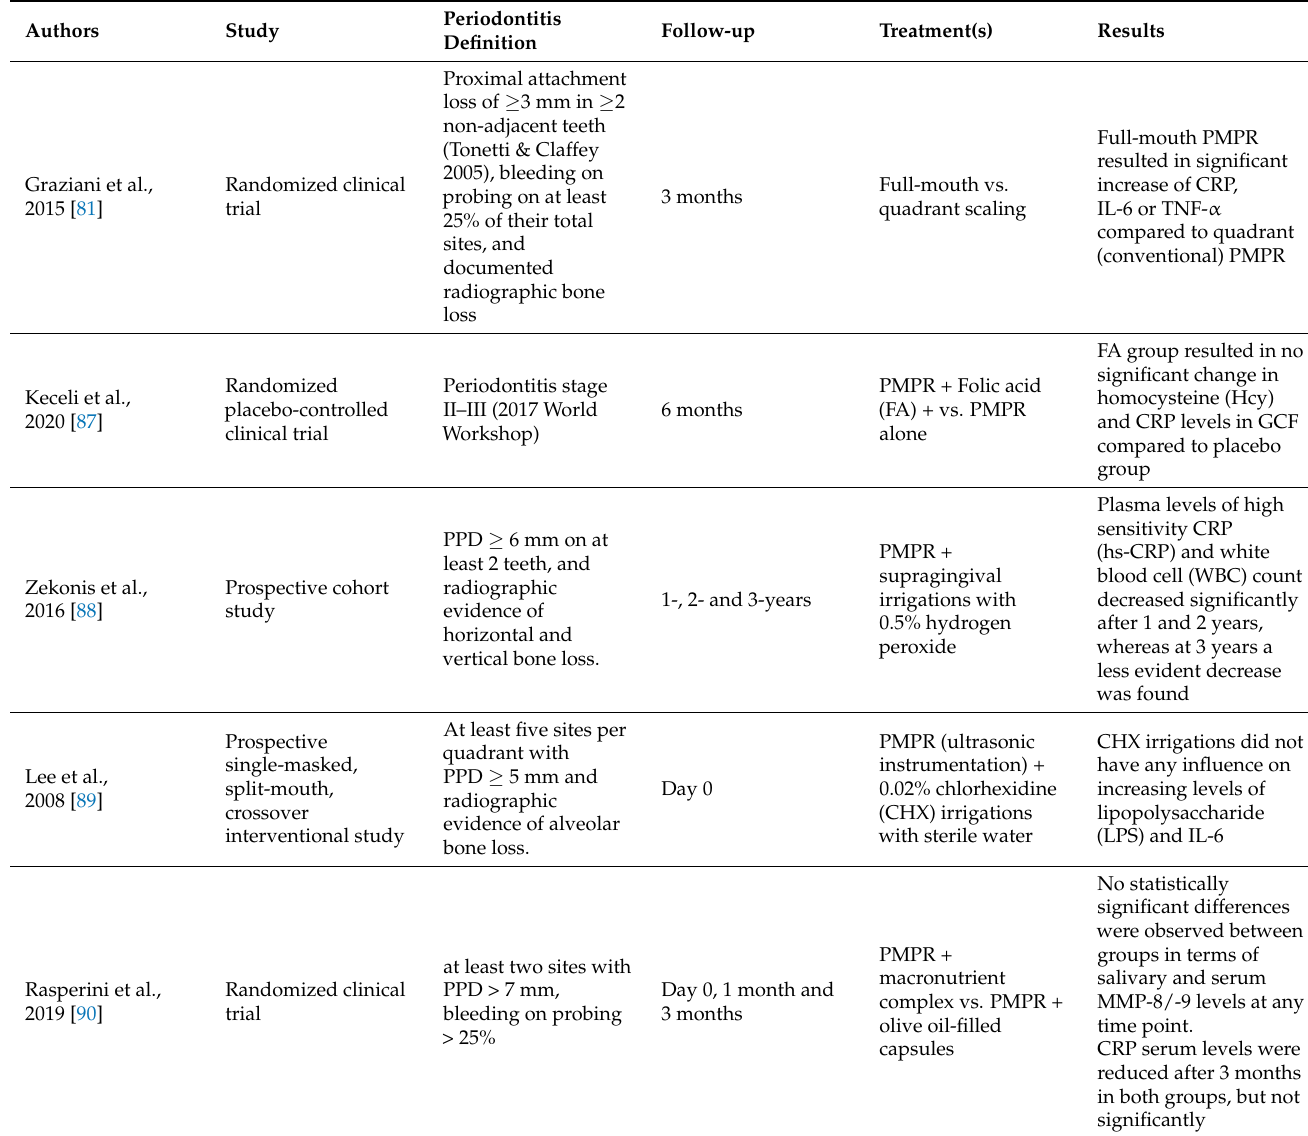
Table 1. Brief summary of studies investigating methods to reduce the systemic impact of professional mechanical plaque removal